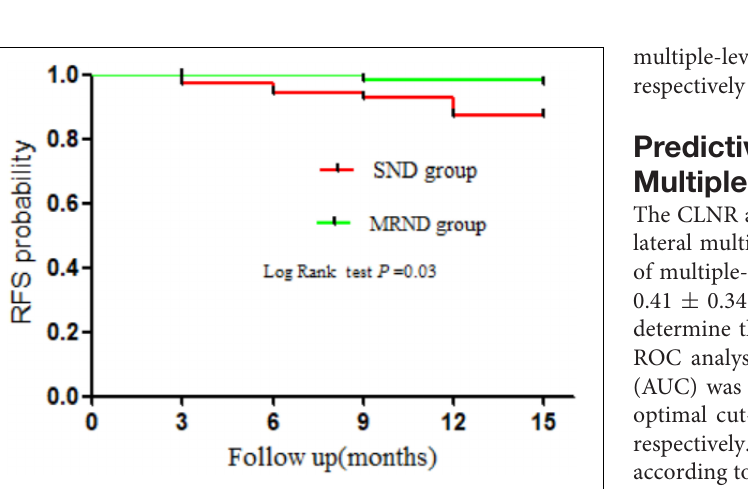
FIGURE 3 | Distribution of the lateral neck lymph node metastasis. (A) Single-level metastasis. (B) Two-level metastasis. (C) Three-level metastasis.